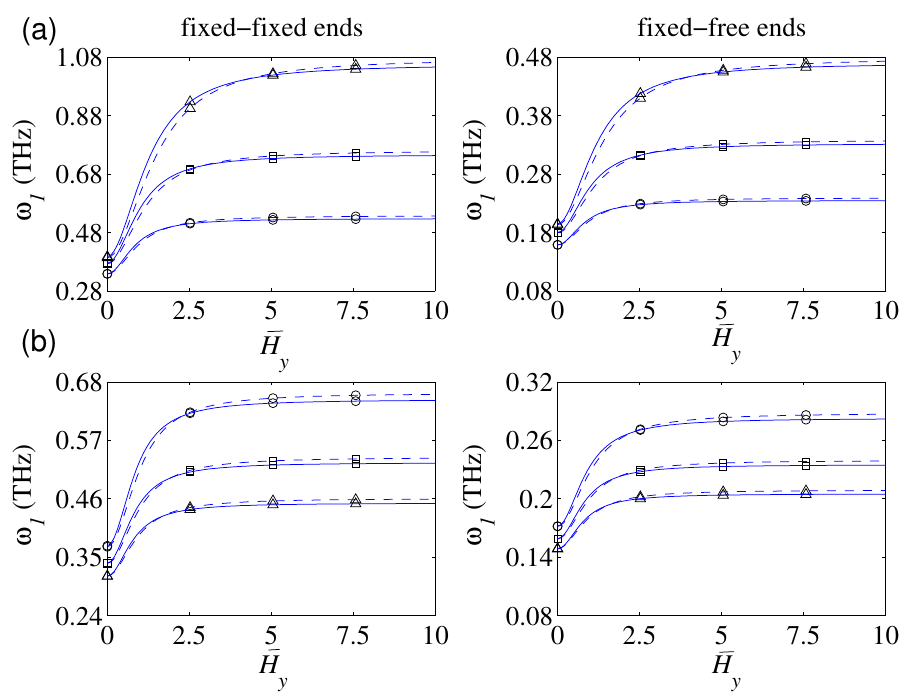
Figure 5. The fundamental frequency in terms of the magnetic field strength with and without considering the surface effect: ( a ) different defect parameters; (( ◦ ) ¯ k 1 = 4, ( (cid:3) ) ¯ k 1 = 8, ( (cid:52) ) k 1 = 16; N = 3), ( b ) different number of defects; (( ◦ ) N = 2, ( (cid:3) ) N = 3, ( (cid:52) ) N = 4; k i = 4); ( e 0 a = 1 nm, l b = 20 nm, D 0 = 1 nm; ( −− ) NET, (—)